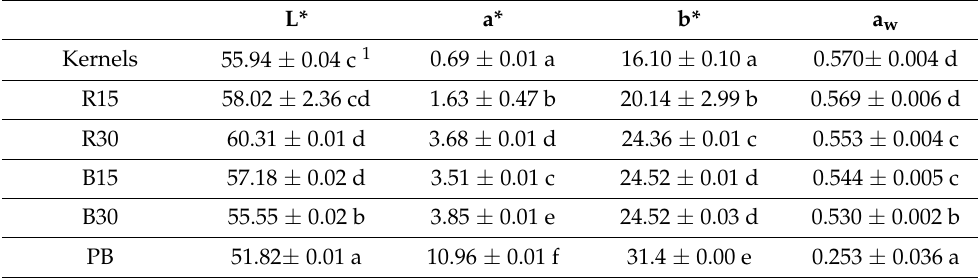
Table 2. Colorimetric parameters (L*, a*, and b*) and water activity (a w ) of unroasted glandless cottonseed kernels, kernels roasted at 150 ◦ C for 15 (R15) and 30 (R30) min, and their corresponding butter products (B15 and B30). Data of commercial Skippy creamy peanut butter (PB) was measured for comparison. Data are present in the format of average ± standard deviation ( n = 3). L*